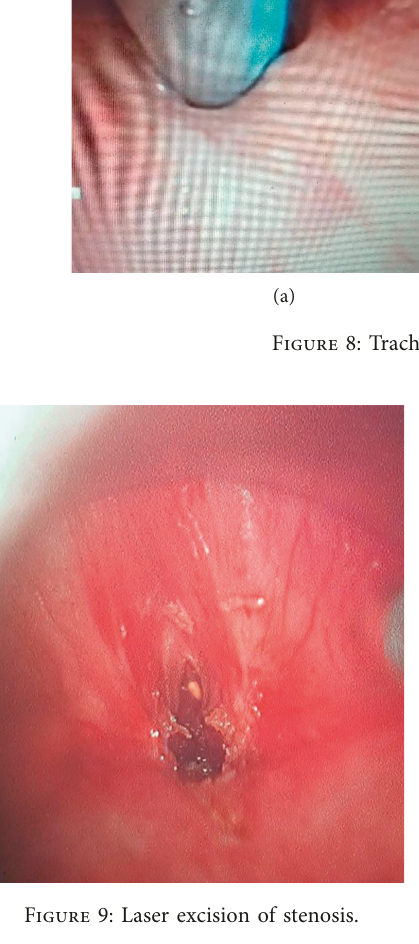
Figure 10: Male and female pie graph. Table 1: Reason for